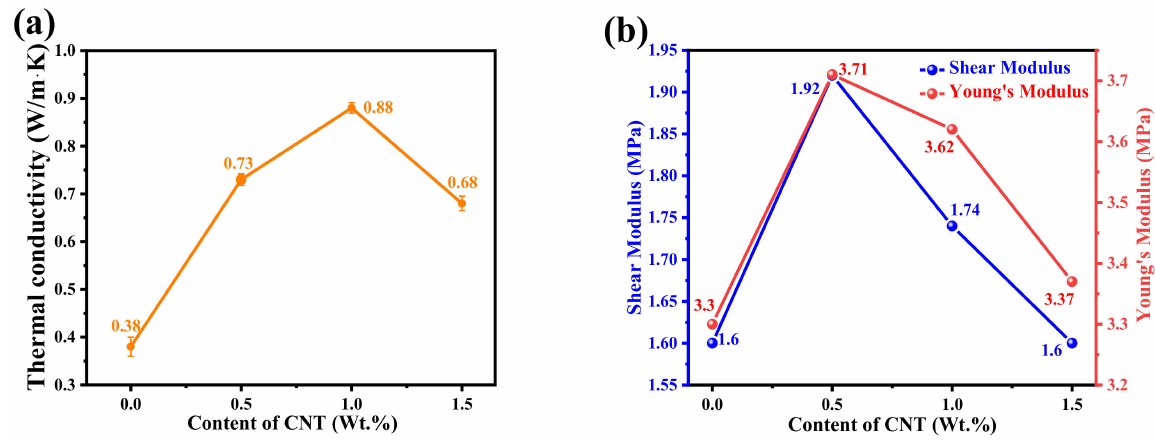
Figure 6. ( a ) Thermal conductivity, ( b ) Young’s Modulus and Shear Modulus of